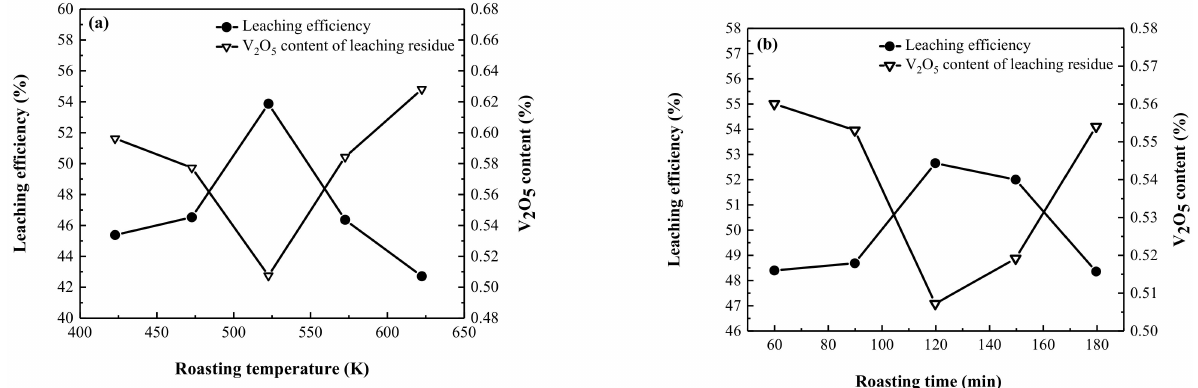
Figure 3. Effects of ( a ) roasting temperature and ( b ) roasting time on vanadium